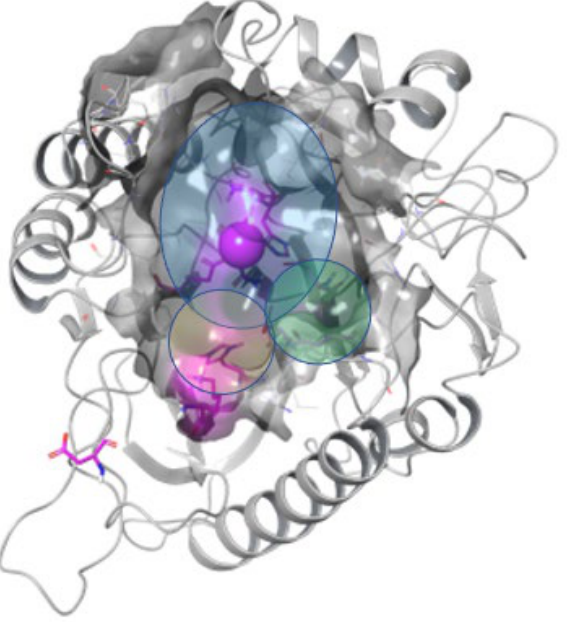
Figure 7. Illustration of the target pocket to which compounds were redocked. The target pocket includes the substrate binding pocket that is characterized by its hydrophobic character and the presence of the primary Mg 2+ ion (Magenta sphere), which is essential for the catalytic activity of nSMase2. The area accessible for small molecules is arbitrarily divided into three zones: I, II and III, illustrated by the blue, yellow and green shading, respectively.